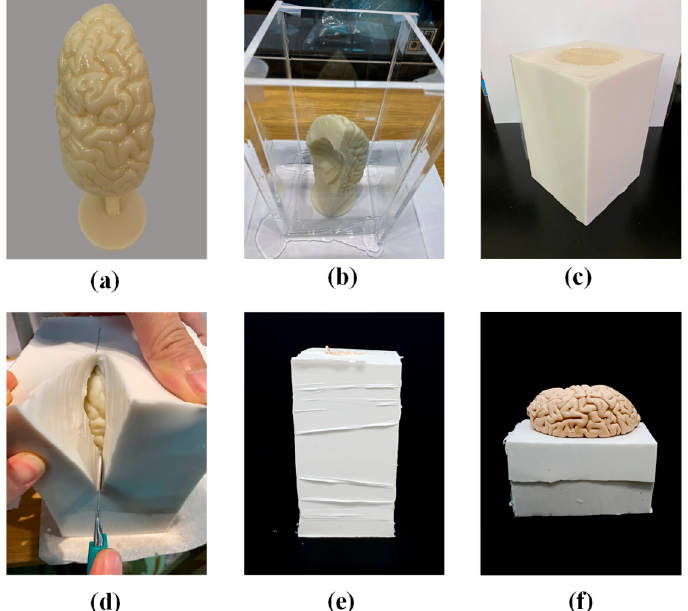
Figure 2. ( a ) Mold of brain lobe printed using a 3D printer (Fortus 360mc, Stratasys) with acrylonitrile butadiene styrene (ABS); ( b , c ) the mold was fixed within a transparent box into which white silicon was poured to create a cast; ( d ) the silicon mold was sliced open using a knife and then peeled back to remove the ABS mold from within; ( e ) beige-colored jelly mixture was poured into the cavity; ( f ) to create a realistic model of the brain lobe.